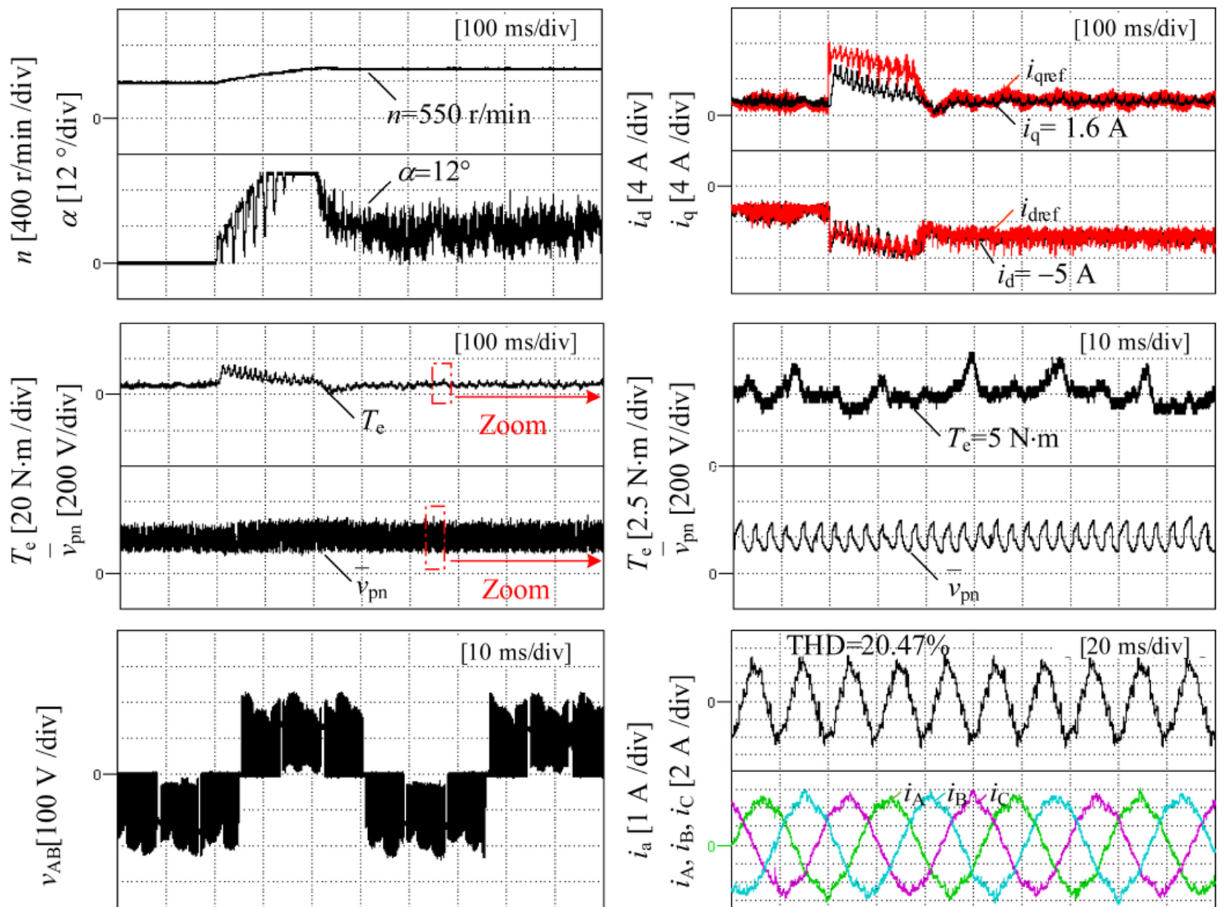
Figure 19. Experimental waveforms of operation Region C.